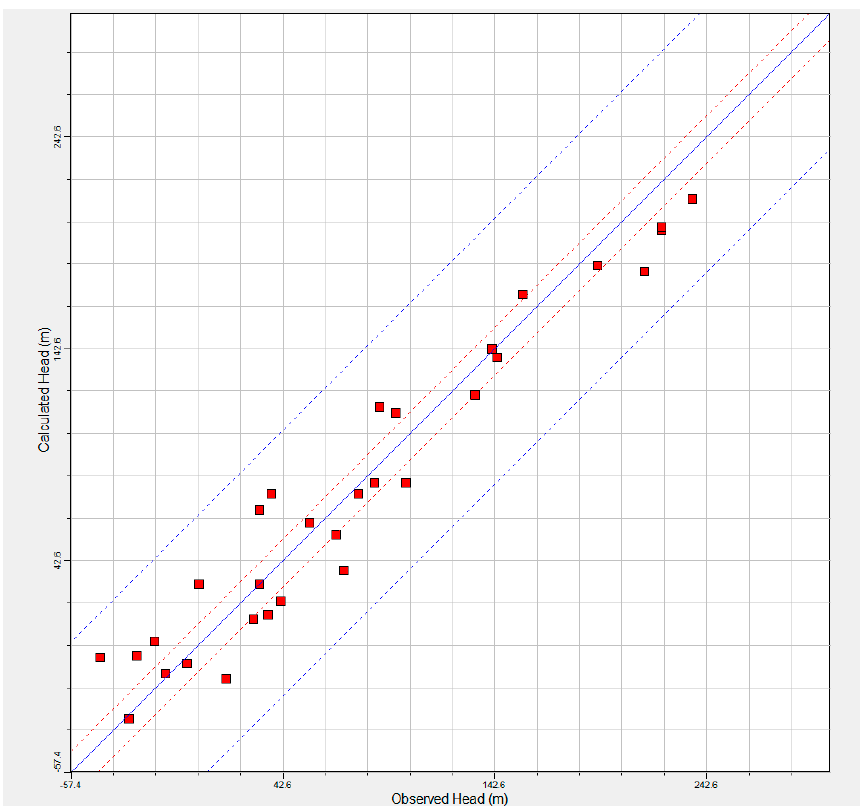
Figure 6. The observation vs calculated heads are presented with red rectangles, red dots present 95% confident interval and blue dots 95% interval. The Normalized Root Mean Squared (NRMS) is 7.49%.